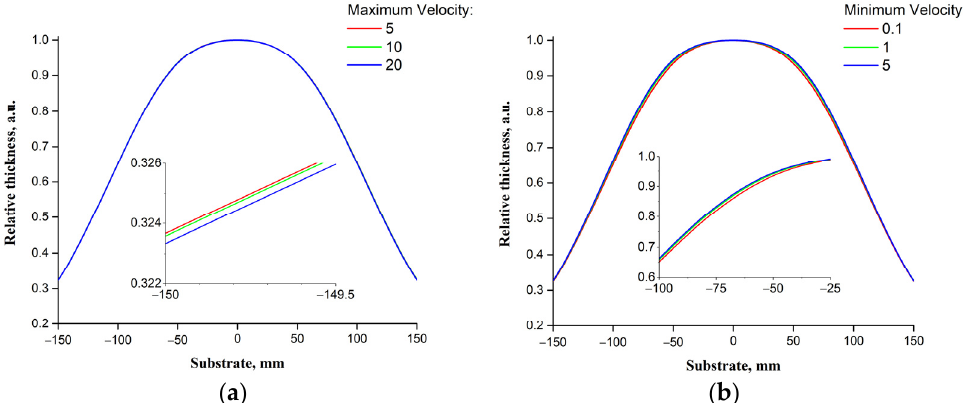
Figure 8. Dependencies of the relative thicknesses of the films on the parameters Max Velocity ( a ) and Min Velocity ( b ).